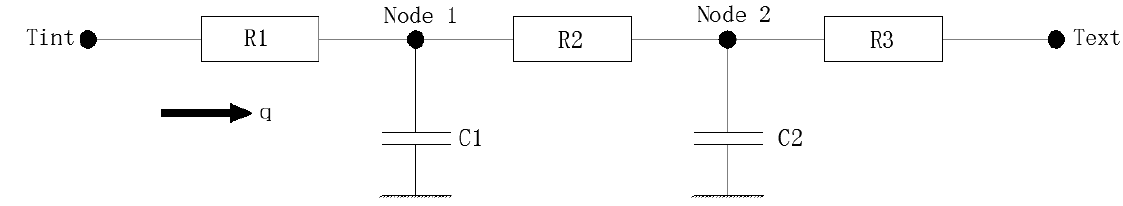
Figure 2. A 3R2C Network Model.